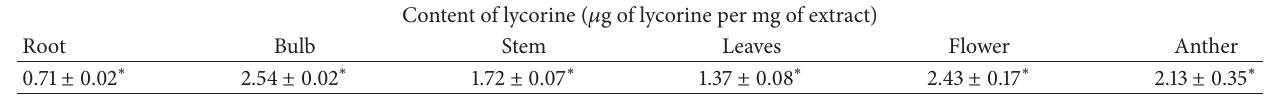
Table 2: Content of lycorine (dry weight) in the extracts of different parts of H. littoralis wild plant. Content of lycorine ( 𝜇 g of lycorine per mg of extract)